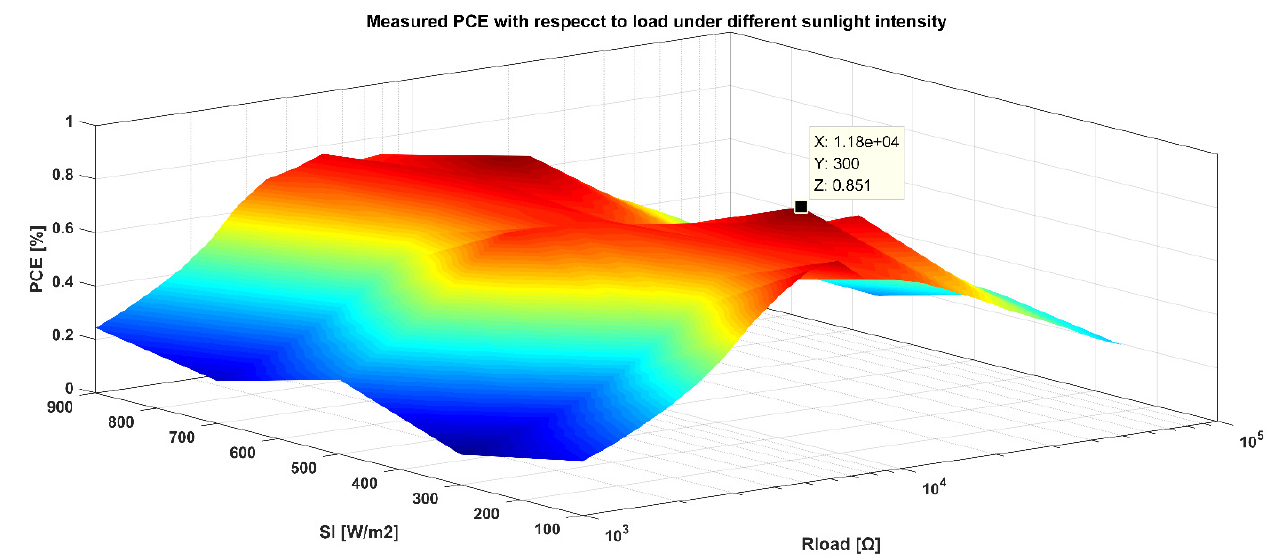
Figure 18. Measured output power under different light intensity.